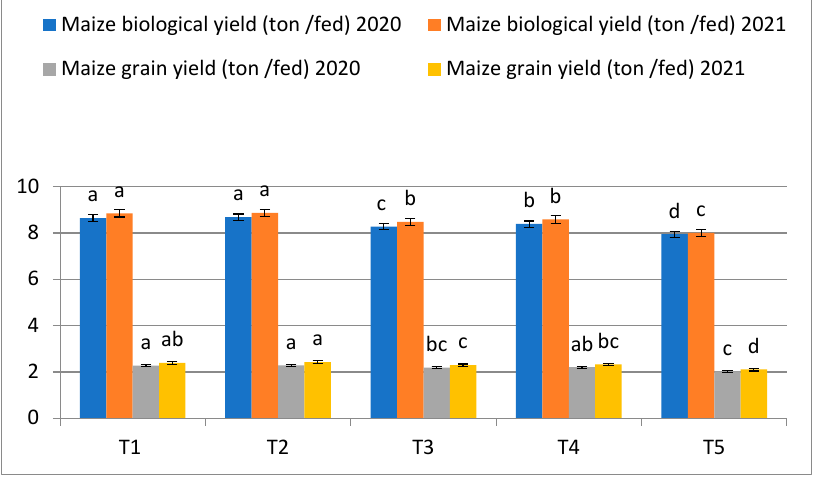
Figure 2. The effect of fertilizer treatments on maize biological and grain yield (ton / fed) under intercropping system during 2020 and 2021 seasons. Different alphabetic letters represent the significant differences among the treatments at p < 0.05, according to Duncan’s test. Table 5. The effect of fertilizer treatments on maize yield and some of its components under inter- cropping system during 2020 and 2021 seasons.